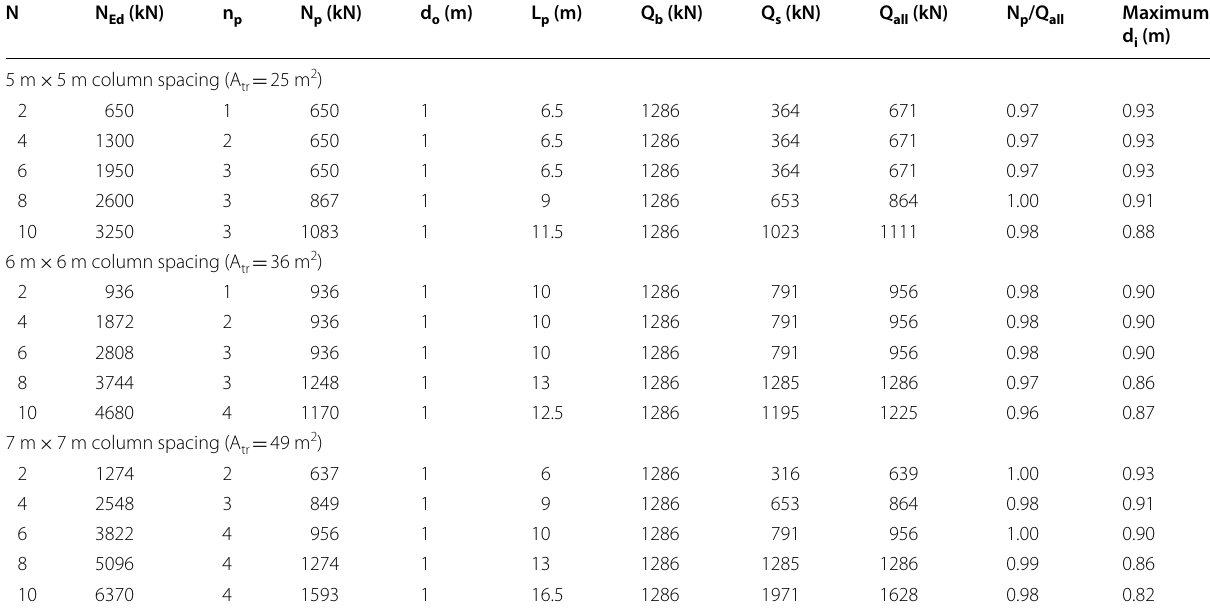
Table 1 Design of the pile foundation.